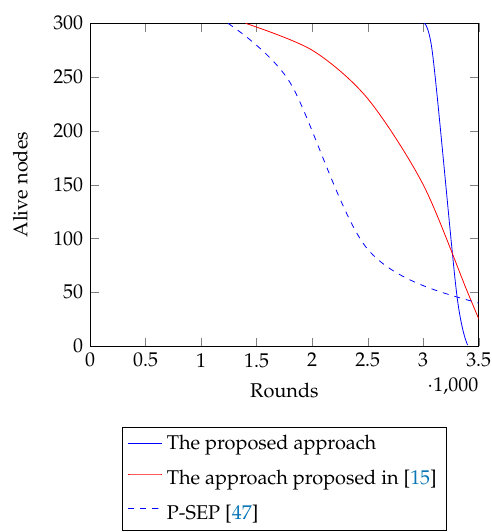
Figure 6. Comparison among the proposed approach, the approach presented in Ref. [15], and P-SEP [47] in terms of number of alive nodes per round. Table 4. The proposed approach vs. the approach presented in Ref. [15] vs. P-SEP [47] in terms of FND, HND, and LND. Clustering Approach FND HND LND The proposed approach